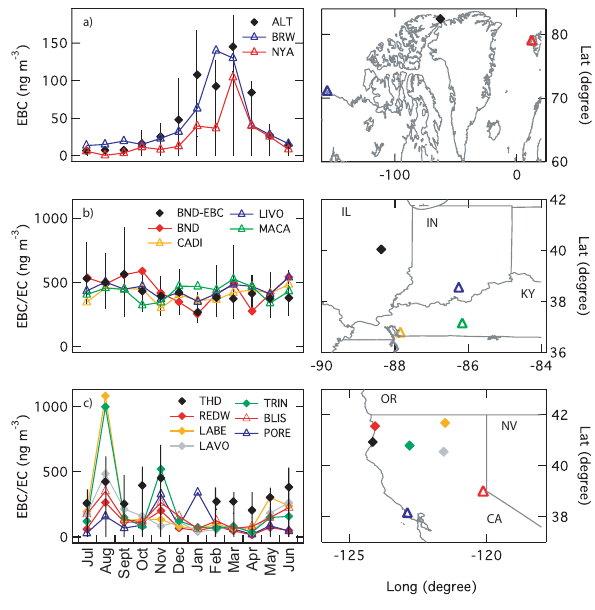
Fig. 2. 50th percentile (black diamonds) and 25th–75th percentile range (black lines) of EBC concentrations at Alert (a) , Bondville (b) , and Trinidad Head (c) , together with EBC and EC experimental values at Point Barrow (BRW), Ny–Alesund (NYA), Cadiz (CADI), Livonia (LIVO), Mammoth Cave (MACA), Redwood National Park (REDW), Lava Beds (LABE), Lassen Volcano (LAVO), Trinity (TRIN), Bliss State Park (BLIS), and Point Reyes National Seashore (PORE); closed diamonds represent locations inside the same model grid cell of the study site.